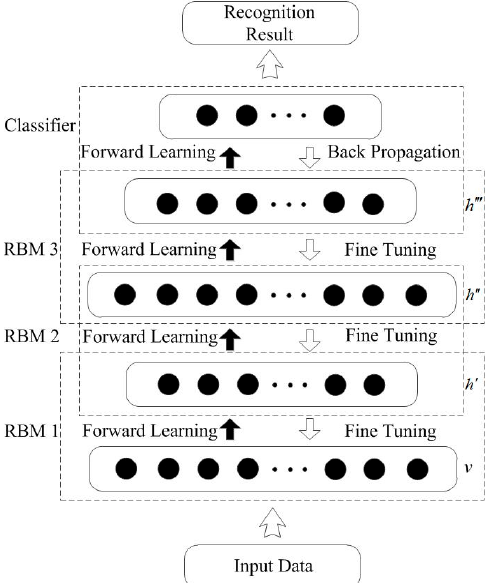
Figure 1. The structure of a deep belief network (DBN).